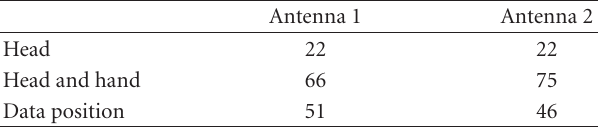
Table 3: Percentage reduction (%) in the e ffi ciency with the di ff erent usage scenarios compared to the nonuser scenario.